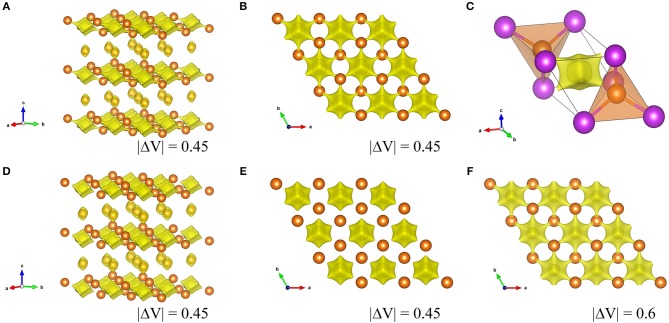
Visualized Mg2+ diffusion pathways by BVS mapping in Mg3Bi2 and Mg3Sb2. (A) overview of Mg3Bi2, (B) the 2D diffusion pathways in 2d tetrahedral sites in Mg3Bi2 from c-axis, and (C) an enlarged image of two MgBi4 tetrahedra with an interstitial octahedron, (D) overview of Mg3Sb2, (E) 2d tetrahedral sites in Mg3Sb2 from c-axis (F) 2d tetrahedral sites in Mg3Sb2 from c-axis at cut off |ΔV| = 0.6.